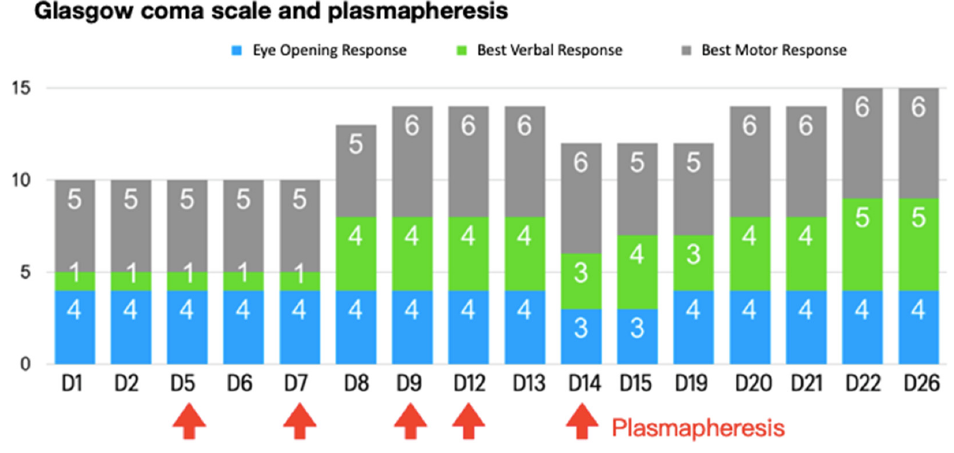
Figure 1. Glasgow coma scale and plasmapheresis during the course .